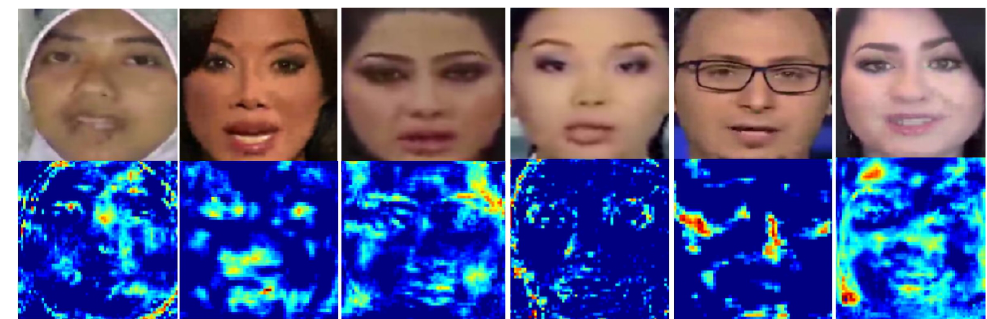
Figure 4. Visualization of attention